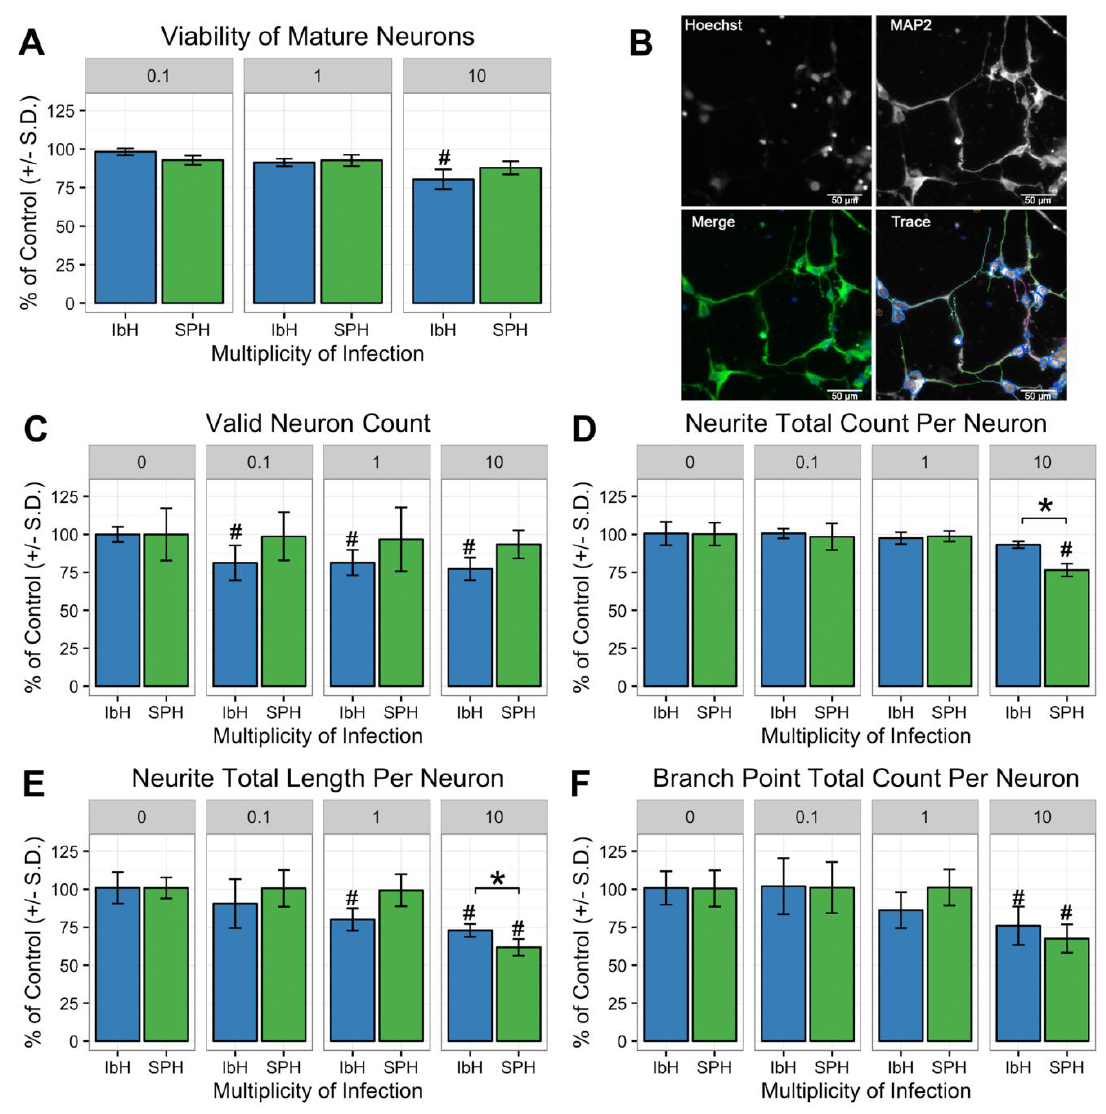
Figure 5. ZIKV infection perturbs neurite outgrowth in human neural progenitor cell-derived neurons. ( A ) At 48 hours post-infection, both African (IbH) and Asian (SPH) isolates had